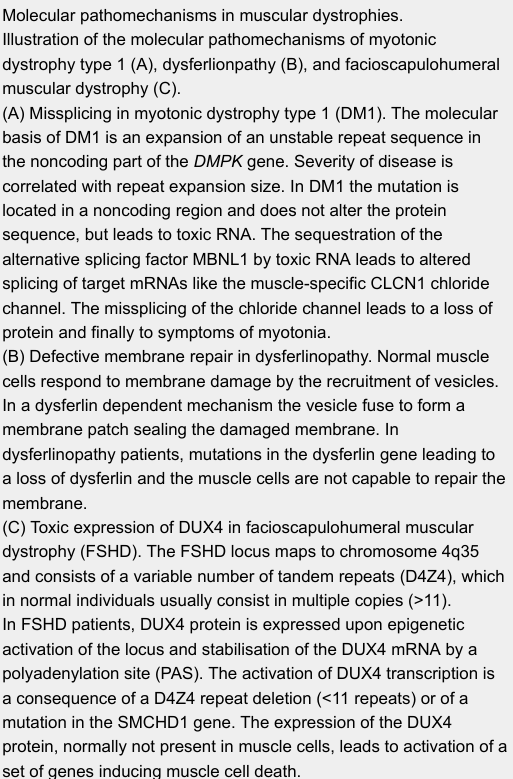
(B) Defective membrane repair in dysferlinopathy. Normal muscle cells respond to membrane damage by the recruitment of vesicles. In a dysferlin dependent mechanism the vesicle fuse to form a membrane patch sealing the damaged membrane. In dysferlinopathy patients, mutations in the dysferlin gene leading to a loss of dysferlin and the muscle cells are not capable to repair the membrane. (C) Toxic expression of DUX4 in facioscapulohumeral